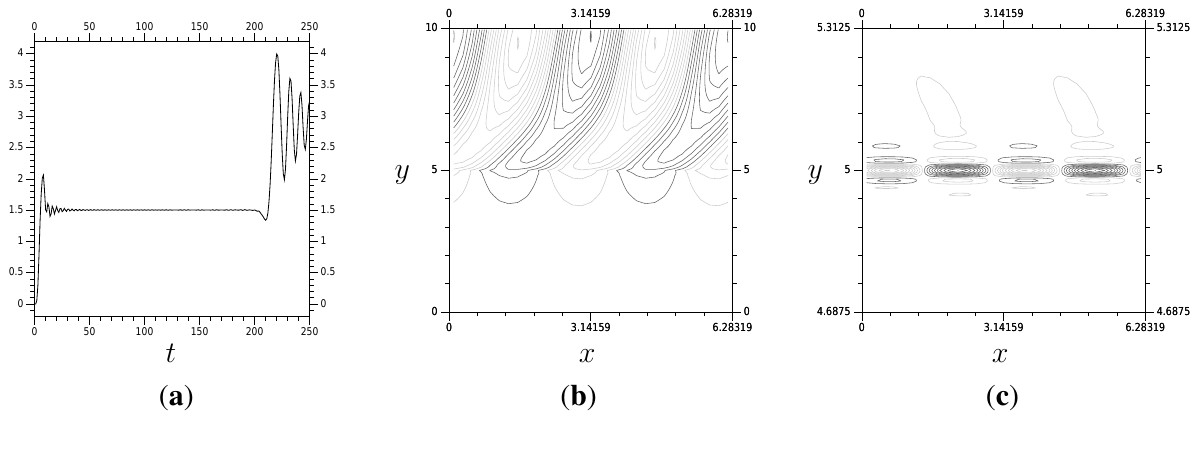
Figure 14. Results from a V − with localized V − double system. The small-scale is over 4 6 Λ = (3 . 0 , 6 . 5) , and 3 “extra” terms are used over both interfaces of Λ . There is a little instability in the flux around t = 200 , but this arrangement is very close to the full V control 6 system, found in Figure 12. ( a ) F ( t ) ; ( b ) P , t = 200 ; ( c ) Z , t = 200